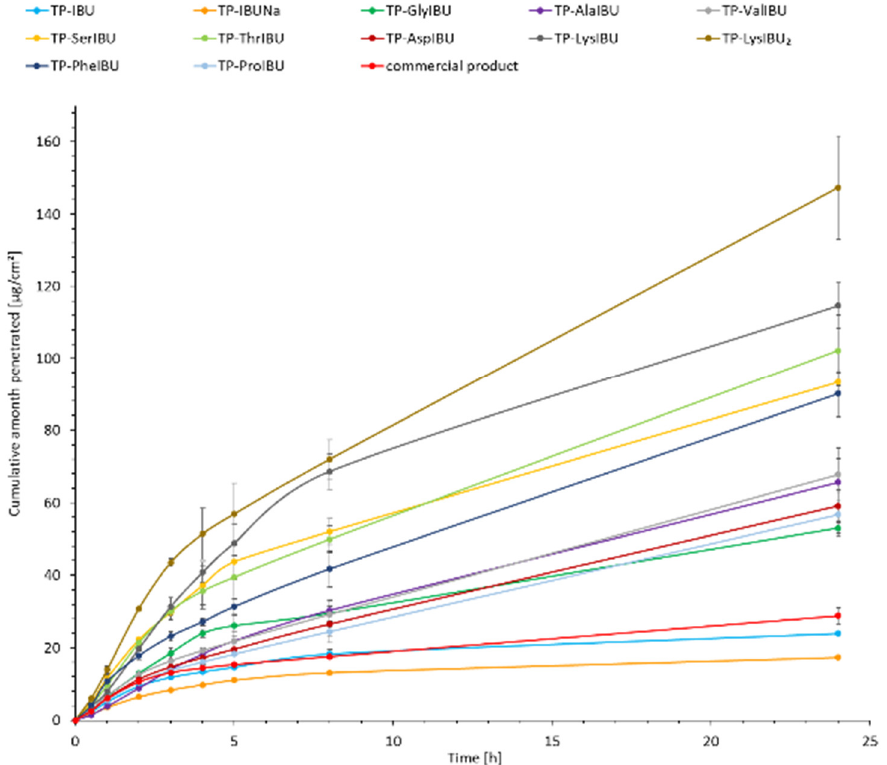
Figure 4. Ibuprofen and amino acid isopropyl ester ibuprofenates permeation profiles. Values are the means with standard deviation; n = 3. Table 5. Skin permeation parameters for ibuprofen and amino acid isopropyl ester ibuprofenates; different letters indicate significant differences between the tested compounds, α = 0.05, mean ± SD, and n = 3. The statistically significant difference was estimated by ANOVA using Tuckey’s